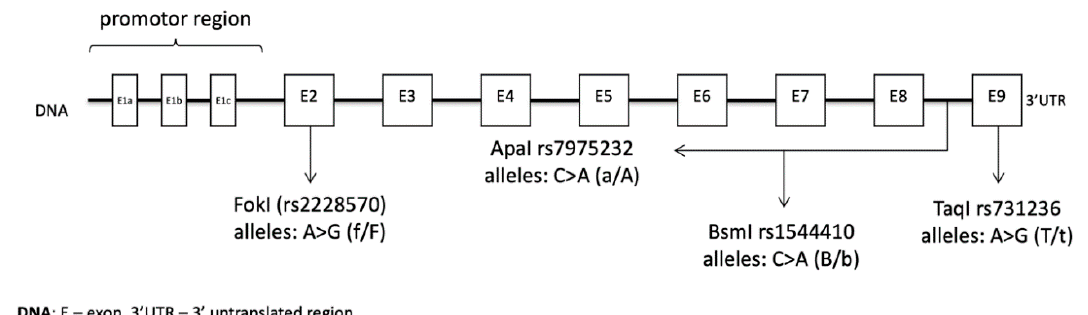
Figure 2. The location and characteristic of VDR polymorphism (based on Single Nucleotide Polymorphism Database— dbSNP).